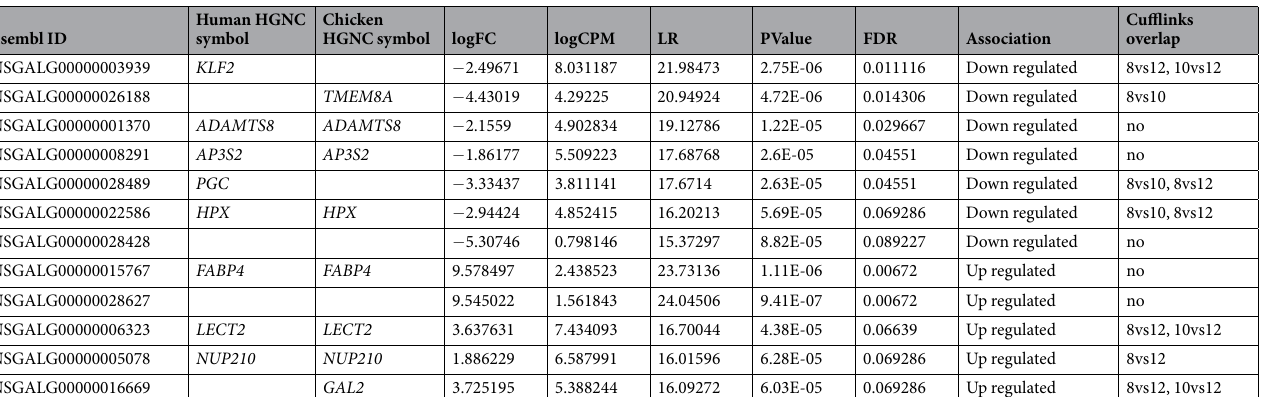
Table 3. DEGs identified in the kidney from chickens fed different Ca concentrations, using the edgeR